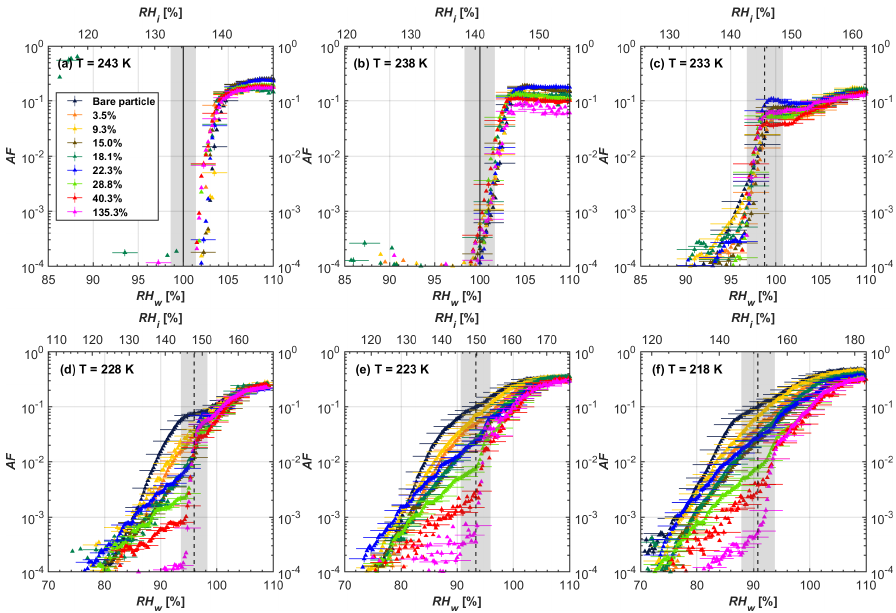
Figure B3. RH scans for bare and coated 200nm FW200 soot particles at eight different coating wt% corresponding to the 1µm OPC channel, presented as AF as a function of RH. Black solid lines represent water saturation conditions according to Murphy and Koop (2005). Black dashed lines denote the expected RH values for homogeneous freezing at T < HNT (Koop et al., 2000). The grey-shaded areas show the possible RH uncertainty calculated for water saturation and homogeneous freezing conditions. The percentage number represents the H 2 SO 4 coating mass ratio to the bare particle mass.